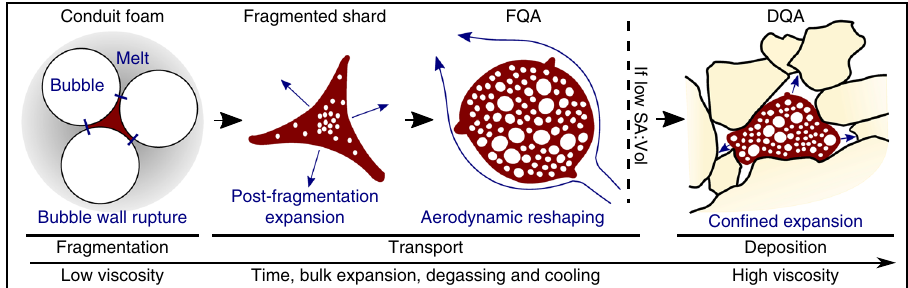
Fig. 7 Conceptual model showing the generation of fl ight quenched achneliths (FQAs) and deposit quenched achneliths (DQAs). A foam is fi rst fragmented generating shards, due to their low viscosity, they continue to degas. As the skin forms through cooling, they become a closed system and in fl ate. In fl ation continues through transport and the clasts are shaped aerodynamically and to minimise free surface energy. If the surface area to volume ratio (SA:Vol) is high, they harden before impact forming FQAs. If the SA:Vol is low, they remain plastic post-deposition and expand into